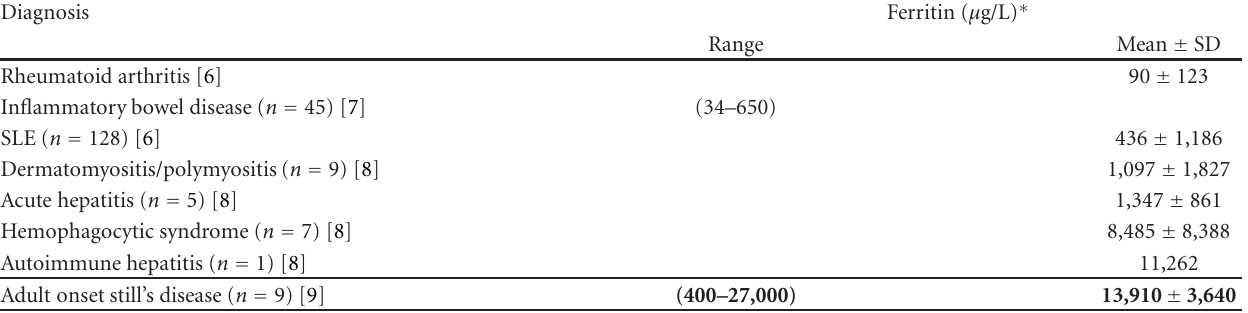
Table 2: Ferritin levels in published surveys of inflammatory